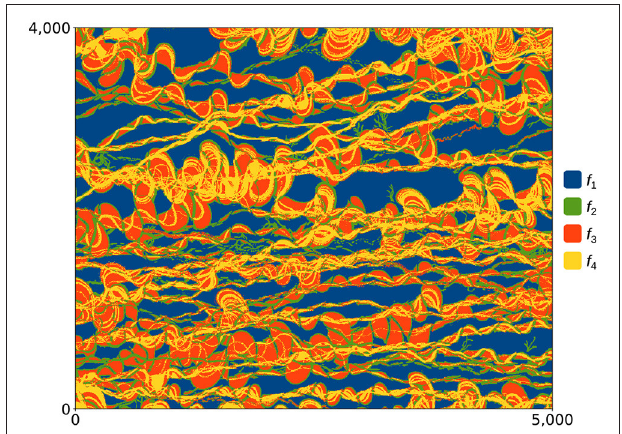
FIGURE 2 | Training